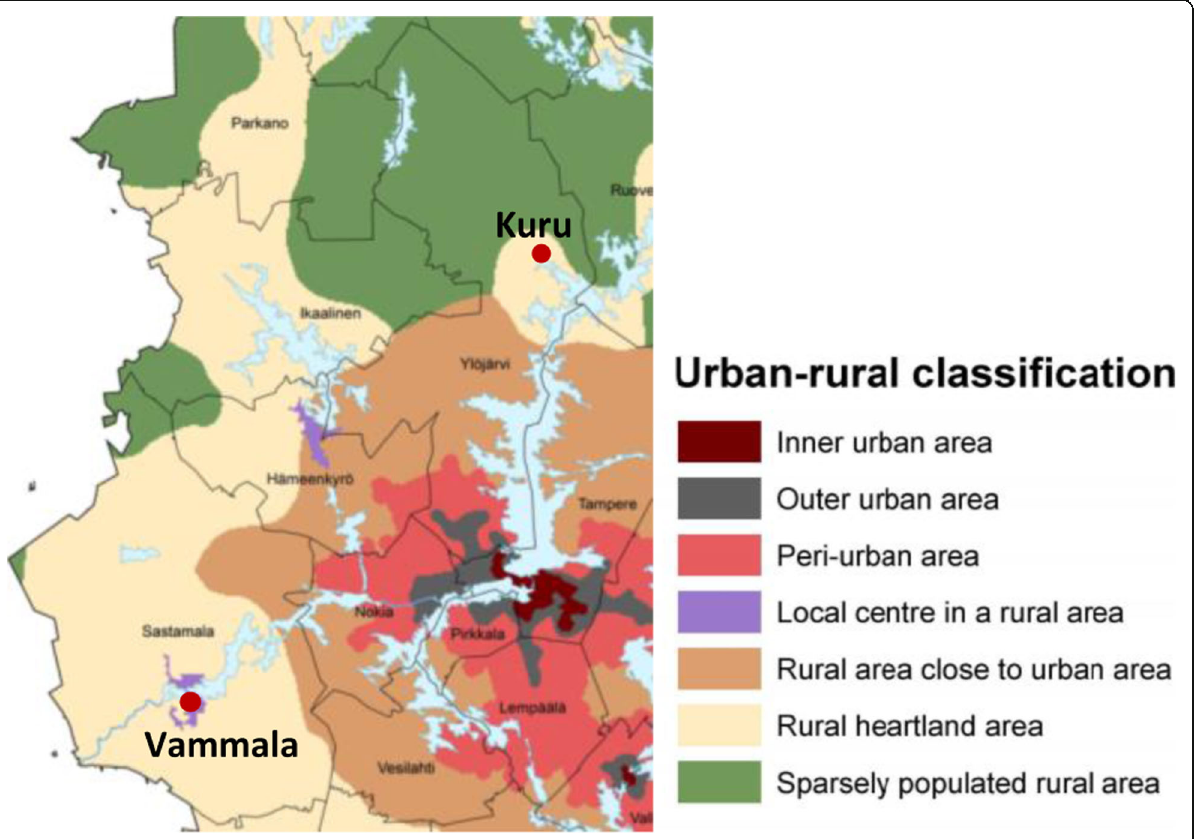
Fig. 3 Urban-rural classification of Kuru and Vammala